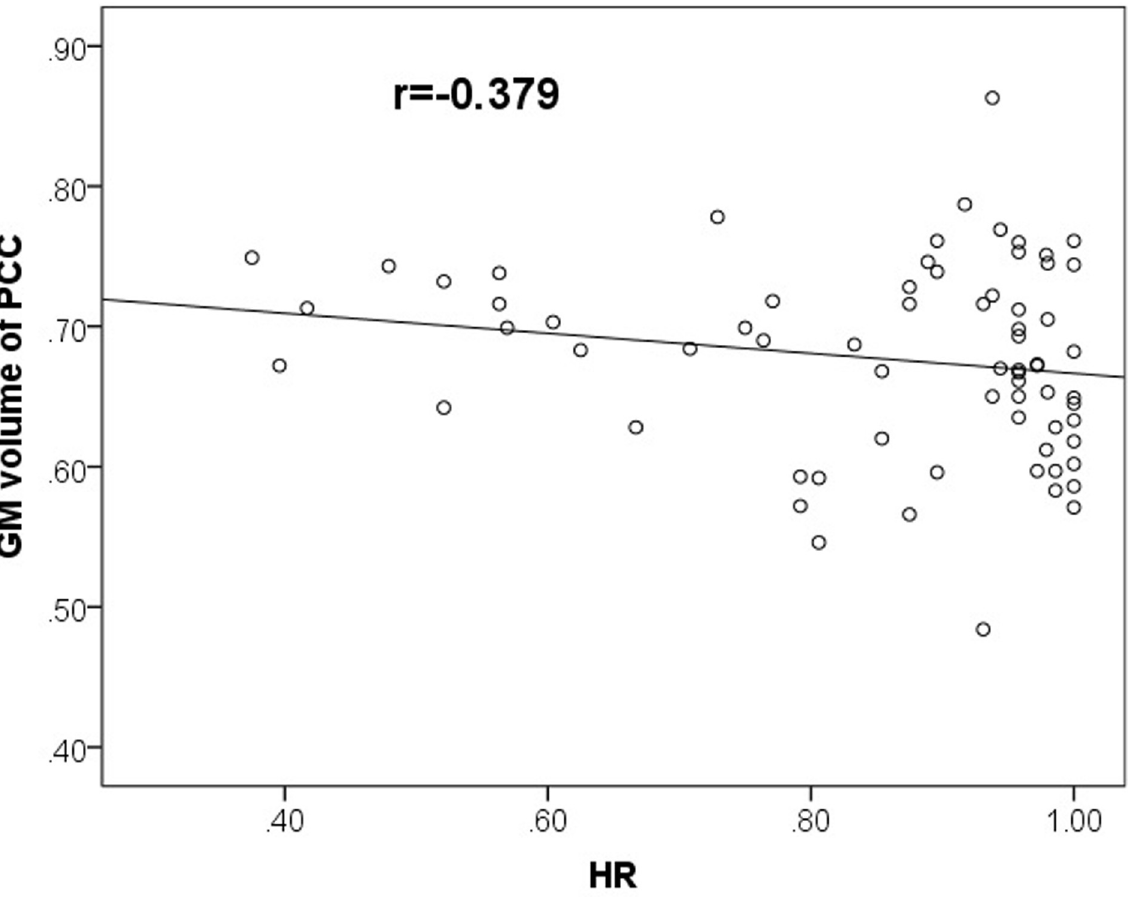
Fig 4. Gray matter volume (GMV) of the PCC was negatively correlated with the HR of the dual